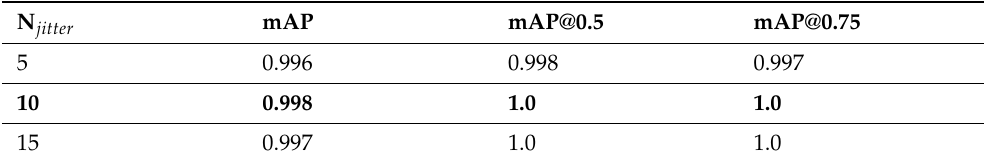
Table 2. The performance comparison by setting different values of jittered boxes using Mask R-CNN [17] with ResNet-101 [19] backbone on 10% label data.